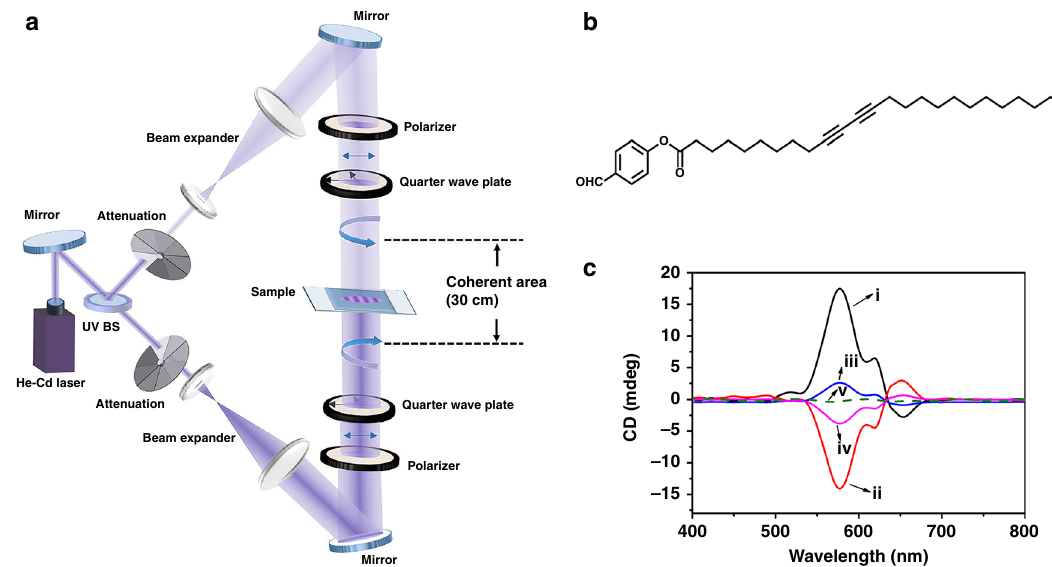
Fig. 1 Experimental set-up, molecular structure and CD spectra. a Experimental set-up for SCL generated by two counter-propagating CPL waves with same frequency and opposite handedness. The coherent length of the laser is 30 cm and the optical path difference of the two counter-propagating CPL waves is less than 2 cm. b The molecular structure of BSDA monomer. c CD spectra of thus-formed PDA fi lms by application of (i) left-handed or (ii) right-handed SCL; (iii) left-handed or (iv) right-handed CPL; (v) LPL, respectively. The wavelength of SCL, CPL and LPL were all 325 nm. The irradiation time was 40